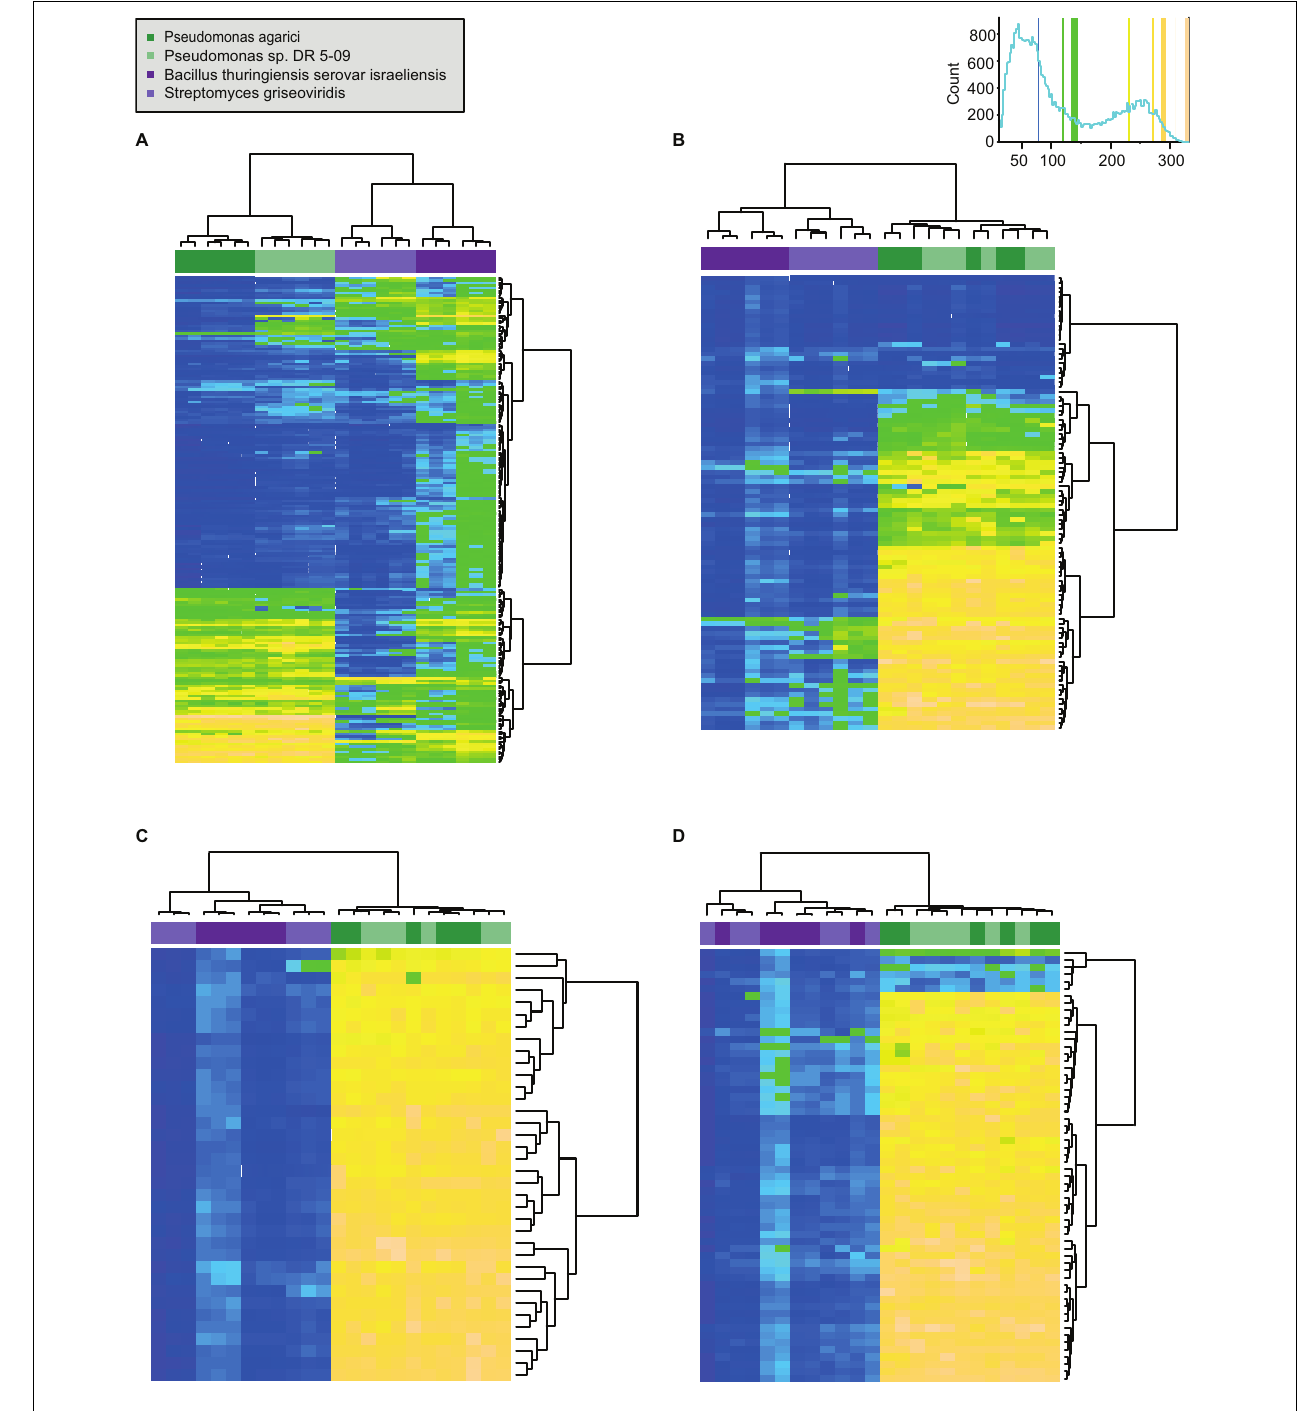
FIGURE 4 | Comparison of respiration behavior of Pseudomonas agarici (dark green), Pseudomonas sp. DR 5-09 (light green), Bacillus thuringiensis serovar israeliensis (purple), and Streptomyces griseoviridis (light purple) on 190 C (A) , 95 N (B) 35 S (C) , and 59 P (D) sources during dark incubation. The heatmap displays maximum curve height values [monitored during 96 h (both Pseudomonas and B. thuriengiensis ) and 192 h ( S. griseoviridis )]. The legend ( upper right corner ) explains the color code from blue to green, while yellow shades indicate low, moderate, and high substrate utilization, assessed as arbitrary Omnilog values. The histogram describes the frequency of maximum height reached for the various substrates. Detailed information about the substrate names and orders are available in Supplementary Material 3 .